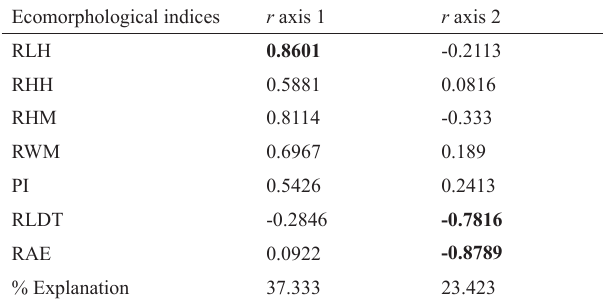
Table 5. Pearson correlation coefficients ( r ) obtained for the first two axes of the Principal Components Analysis (PCA) for seven ecomorphological indices related to feeding behavior in the 19 species analyzed. The indices with the highest correlation coefficients (shown in bold type) were selected for interpretation. Codes: Relative length of the head (RLH); Relative height of the head (RHH); Relative height of the mouth (RHM); Relative width of the mouth (RWM); Protrusion index (PI); Relative length of the digestive tract (RLDT); Relative area of the eye Ecomorphological indices r axis 1 r axis 2